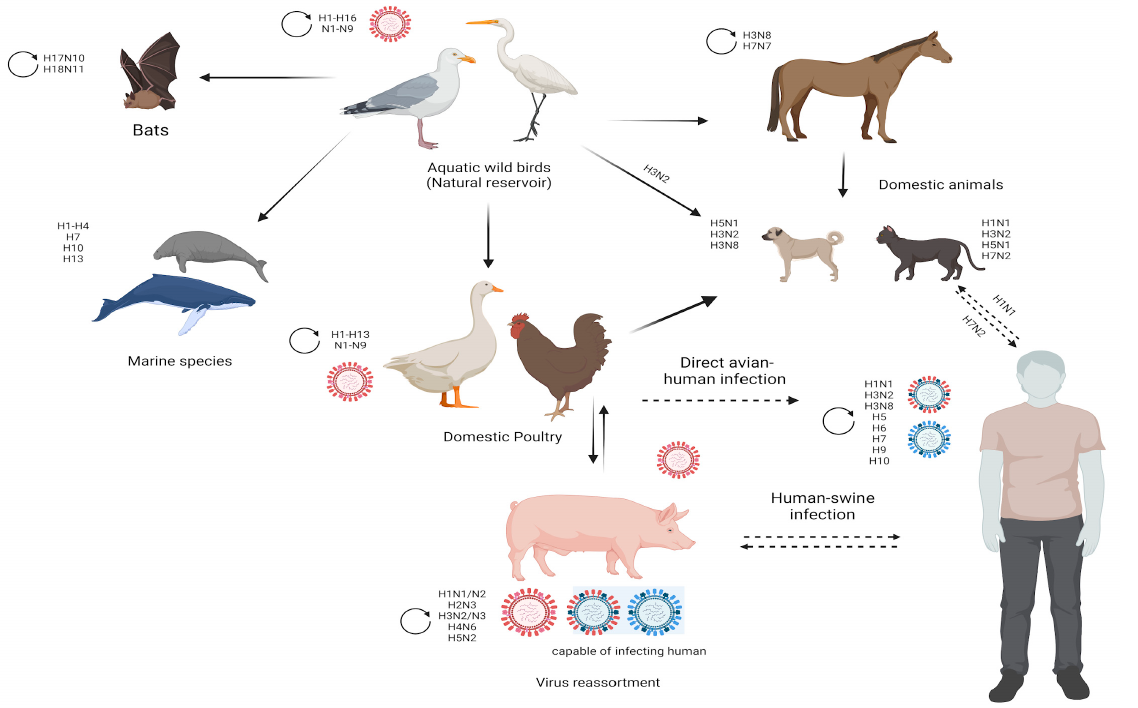
Figure 2. Schematic diagram showing the host range of influenza A viruses. Reservoirs and interspecies transmission events of influenza A viruses and the subtypes involved in these events. Aquatic wild birds represent the natural reservoir of influenza A viruses, from which they can be transmitted to a variety of other hosts. Circled arrows represent continuous virus circulation among wild birds, domestic birds, domestic animals, bats, horses, pigs and humans. (Created with BioRender.com (accessed on 18 March 2023)).